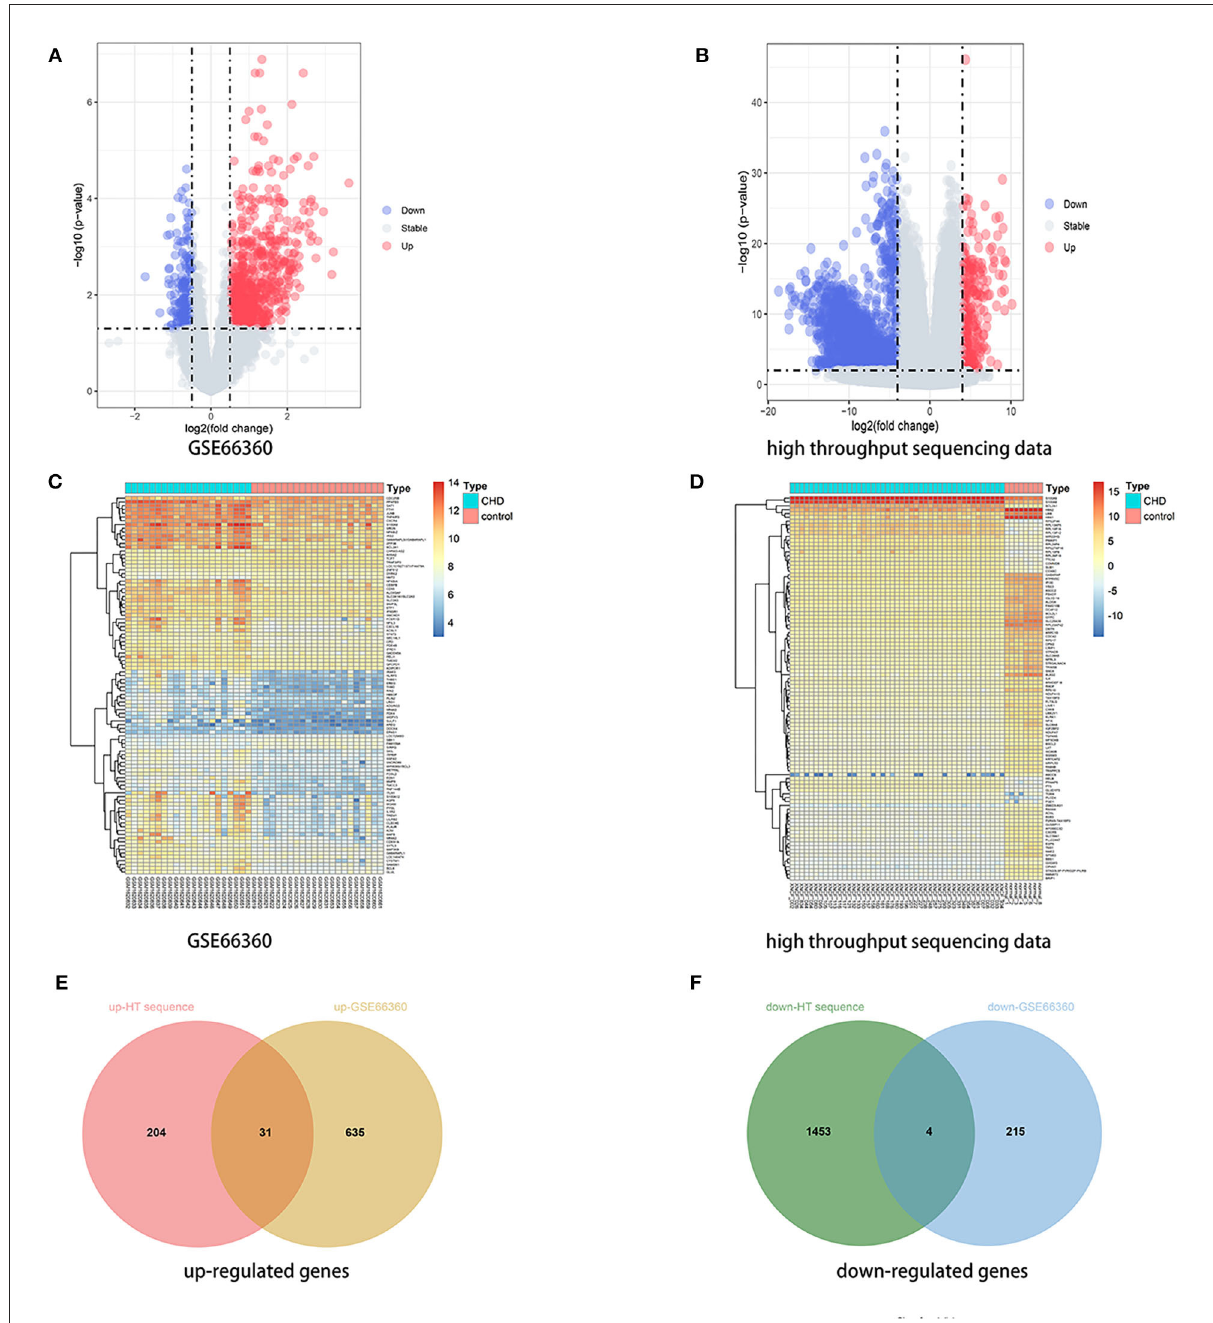
FIGURE1 Identification of DEGs. (A,B) Volcano plot of DEGs between the CHD samples and the healthy samples from the GSE66360 dataset and high throughput sequencing dataset, respectively. Blue plots represent downregulated genes, gray plots represent nonsignificant genes, and red plots represent upregulated genes. (C,D) Heatmap of DEGs between the CHD samples and the healthy samples from the GSE66360 dataset and high throughput sequencing dataset, respectively. Blue rectangles represent low expression and red rectangles represent high expression. (E,F) Venn diagram of overlapped up-regulated and down-regulated DEGs from the two datasets, respectively.